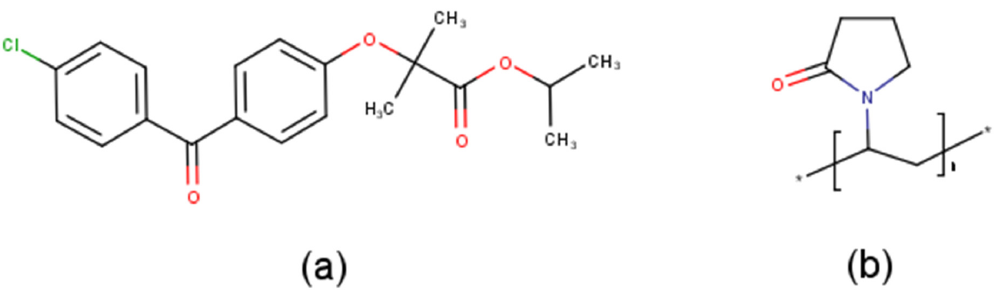
Figure 1. Chemical structures of ( a ) FEN and ( b ) PVP.